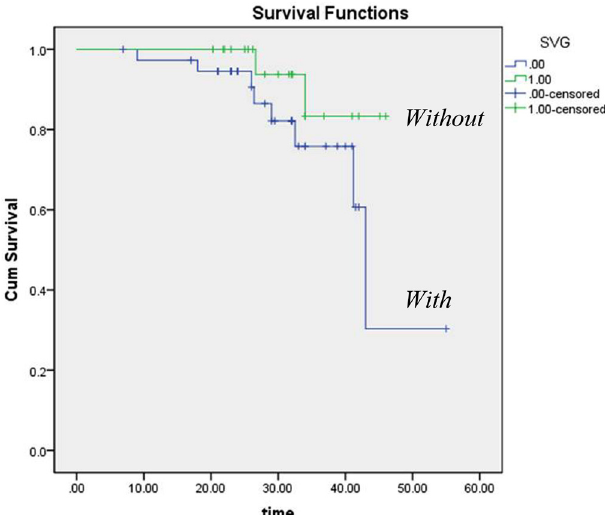
Fig. 4 - Kaplan-Meier analysis revealed that the pathological changes of the saphenous vein graft were not a significant risk factor affecting the survival rate. The long-term survival rate was 83.6%, 78.9% and 91.3% for overall, patients with and without pathological changes of the saphenous vein. SVG= Saphenous vein graft; With= With pathological changes; Without= Without pathological